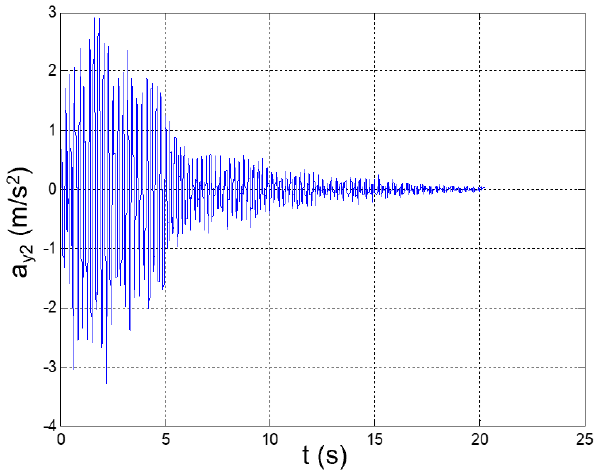
Figure 7. Seismic response, 3rd-floor acceleration (Node 47) with respect to the ground.